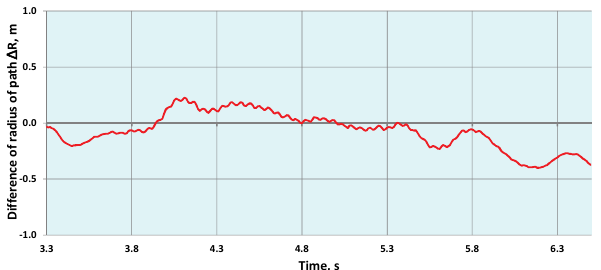
Fig. 5. The difference between predetermined and realized radius of driv- ing, during the test “ride on a circular path” Based on these graphs, you can attempt to make a cor- rection of angle d . this correction will be introduced with a e delay resulting from the characteristics of the control sys- tem of the vehicle in scale.